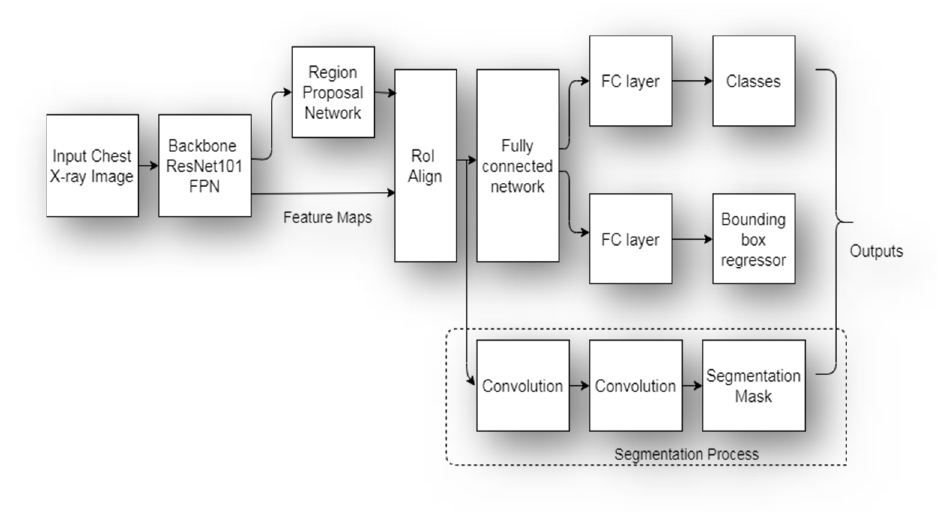
Figure 3. Proposed Mask RCNN Model Architecture.